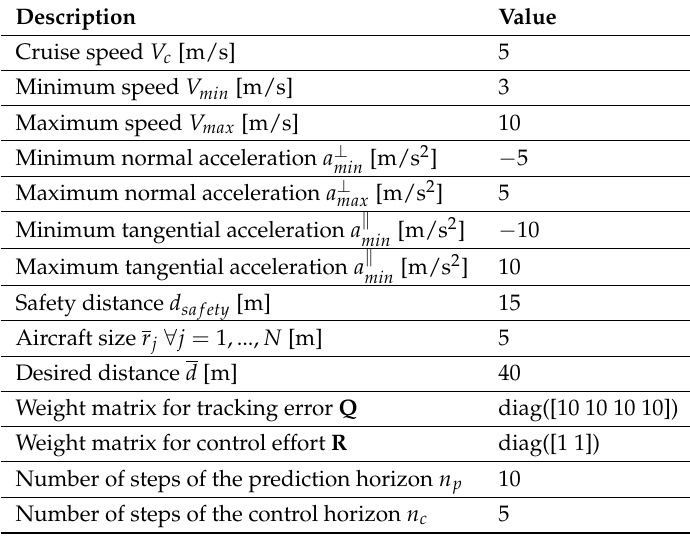
Table 1. Simulation